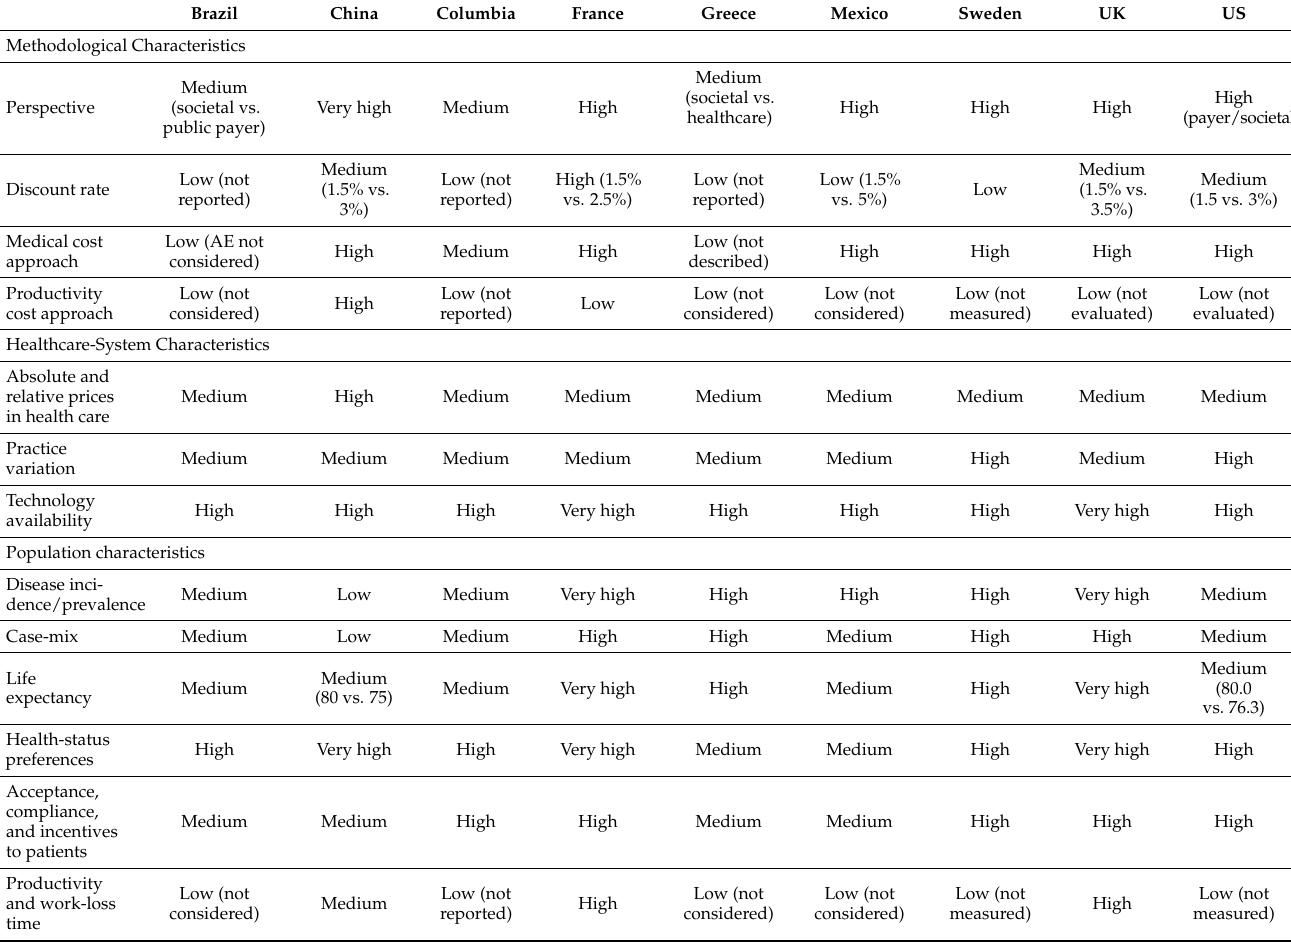
Table 5. Correspondence between study country and